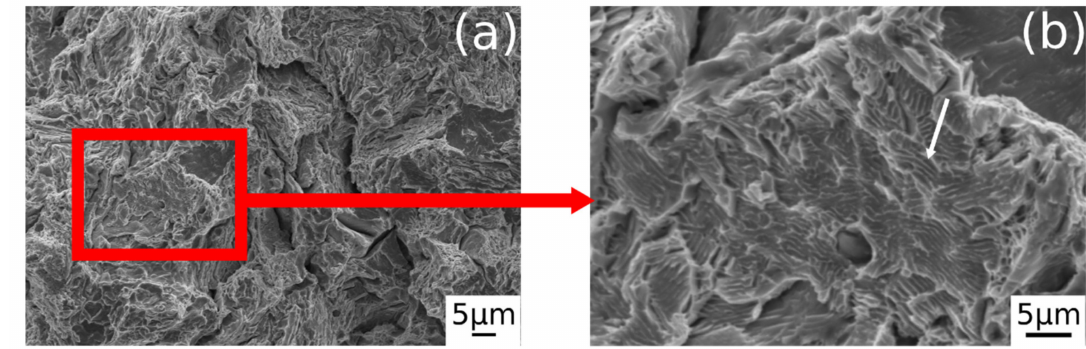
Figure 15. ( a ) SEM fractography of the sample in annealed condition ( b ) detail of a pearlitic fractured grain. White arrow in ( b ) indicates fracture surface of a pearlitic